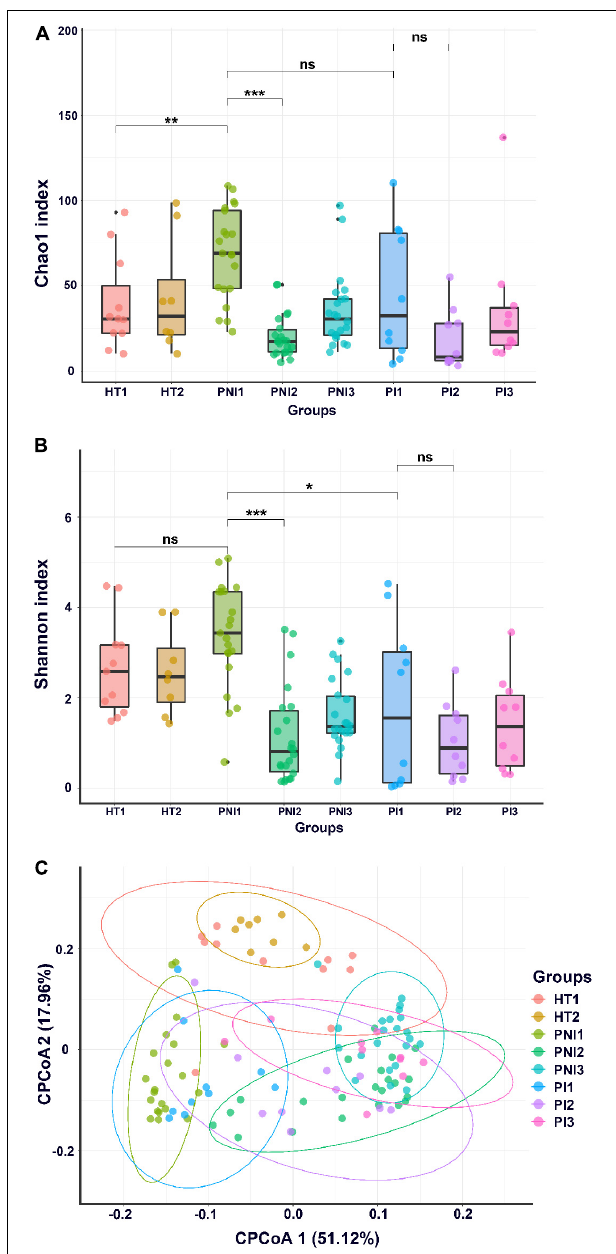
FIGURE 1 | α -diversity and β -diversity of gut microbiota. α -diversity indices, including Chao1 (A) and Shannon index (B) , and (C) β -diversity (CPCoA, covariate adjusted principal coordinates analysis) of gut microbiota of healthy term infants (HT), preterm infants without invasive infections (PNI), and preterm infants with invasive infections (PI). HT1, stool collected within the first week of age; PNI1 and PI1, stool collected within the first week of age; HT2, PNI2, and PI2, stool collected at 4 weeks of age; PNI3 and PI3, stool collected at 7 weeks of age. * p < 0.05; ** p < 0.01; *** p < 0.001; ns, non-significant.